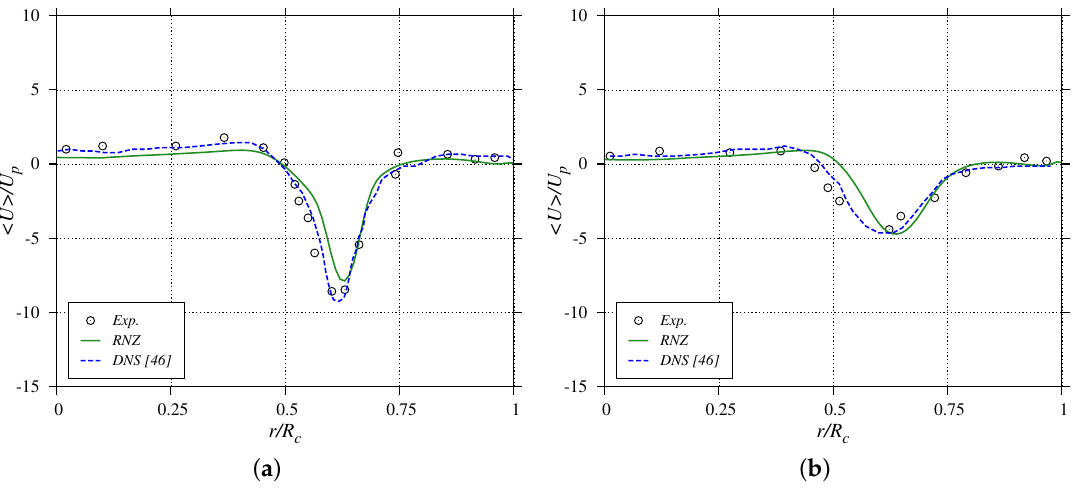
Figure 8. Radial distribution of the averaged axial velocity < U > at θ = 36 ◦ : ( a ) z = − 10 mm; ( b ) z = − 20 mm.